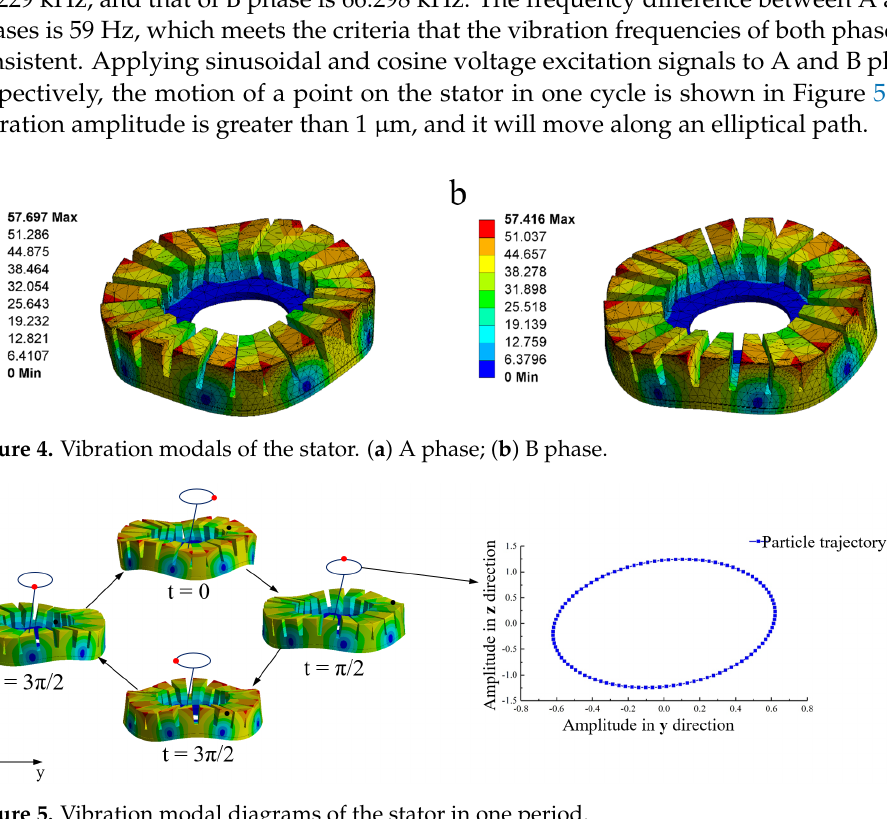
Figure 5. Vibration modal diagrams of the stator in one period. Table 2. Structural dimension parameters of the